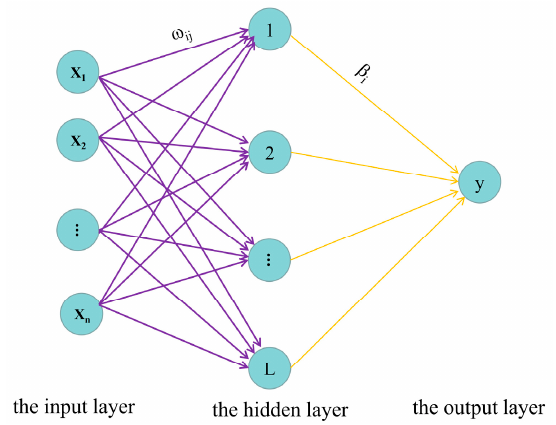
Figure 2. ELM neural network structure diagram.